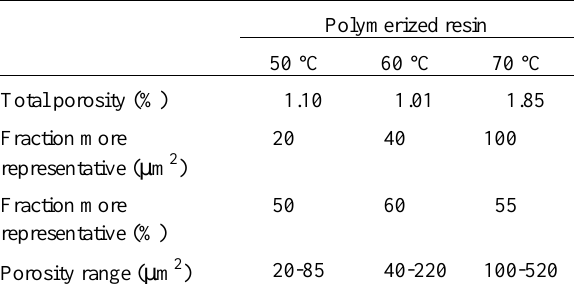
Table 3. Image analysis of the polymerized furfuryl resin at 50, 60 and 70